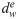
Comparisons of the results using MbD-LF-CPI and the three pool method in (14).(a) Recovered high-frequency conductivity σH. (b) Recovered extracellular volume fraction α, extracellular mean diffusivity dwe, intracellular diffusivity dwi, apparent extracellular ion concentration c¯e and low-frequency mean conductivity σL images, respectively, using MbD-LF-CPI method. (c) Recovered results corresponding to the results in (b) using the three pool model method in (14). To show the difference more clearly, the last two columns zoom in on the area marked by the rectangles.